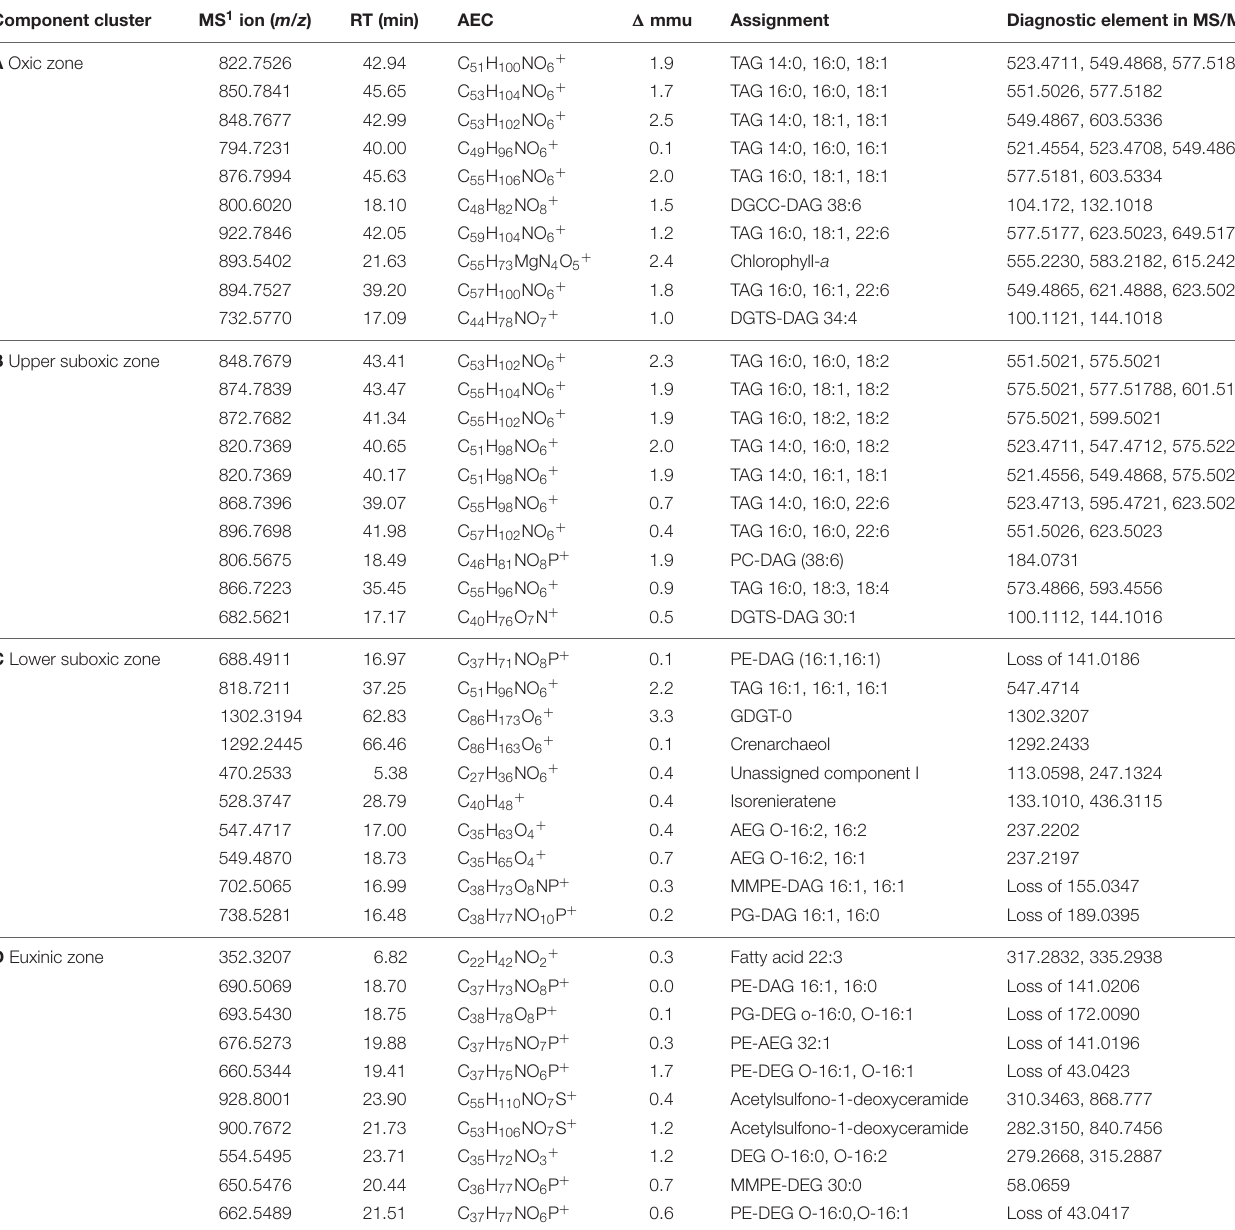
TABLE 2 | The most abundant components of cluster A–D in the Black Sea SPM extracts (2013 expedition). Component